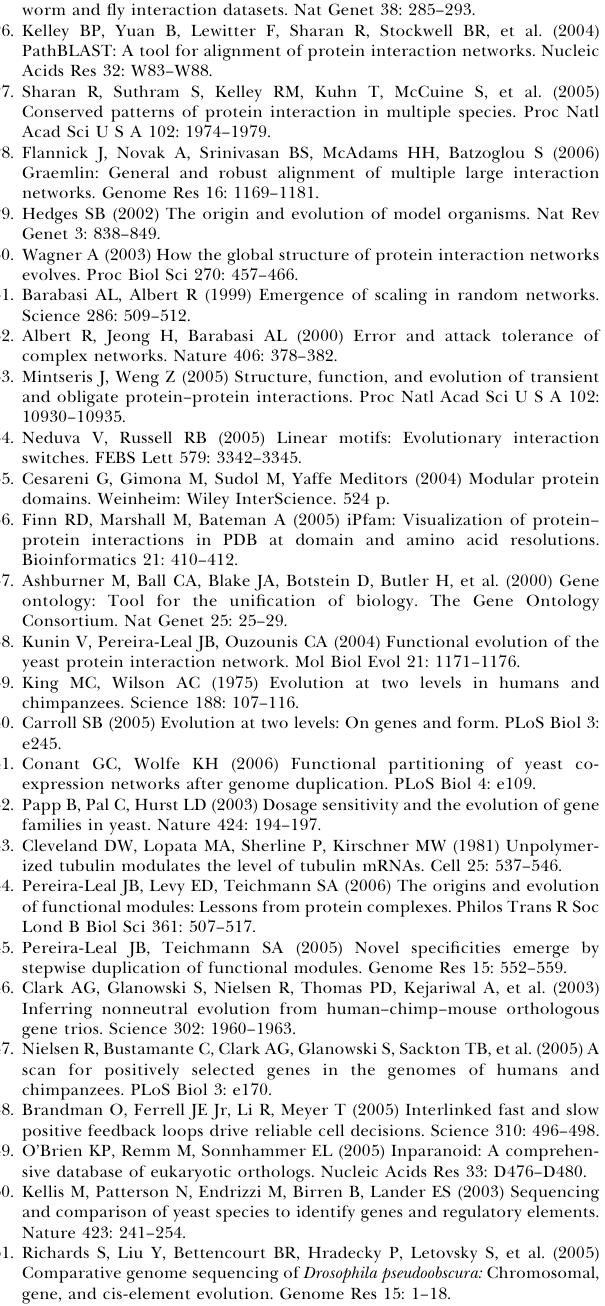
Table S2. Impact of Constraining the List of Domains by Represen- tation in the Difference Species and by the Average Rate of Change To increase the reliability of the rate of change for each domain, we have selected only domains that were represented in most species by at least 20 domains. Of all Interpro domains, 96 observe this condition. Of these 96 domains, eight have an above average rate of change for at least three species studied. We can say that these eight domains consistently contribute to the fast rate of change in most